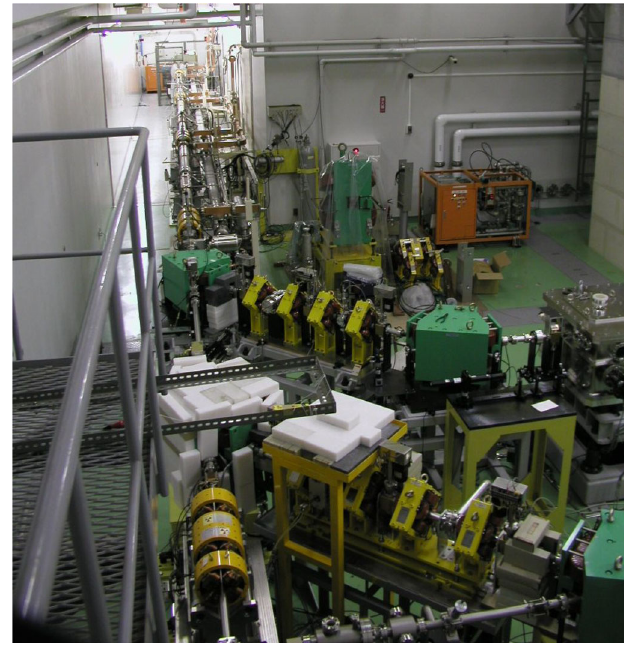
FIG. 9. (Color) Photograph of